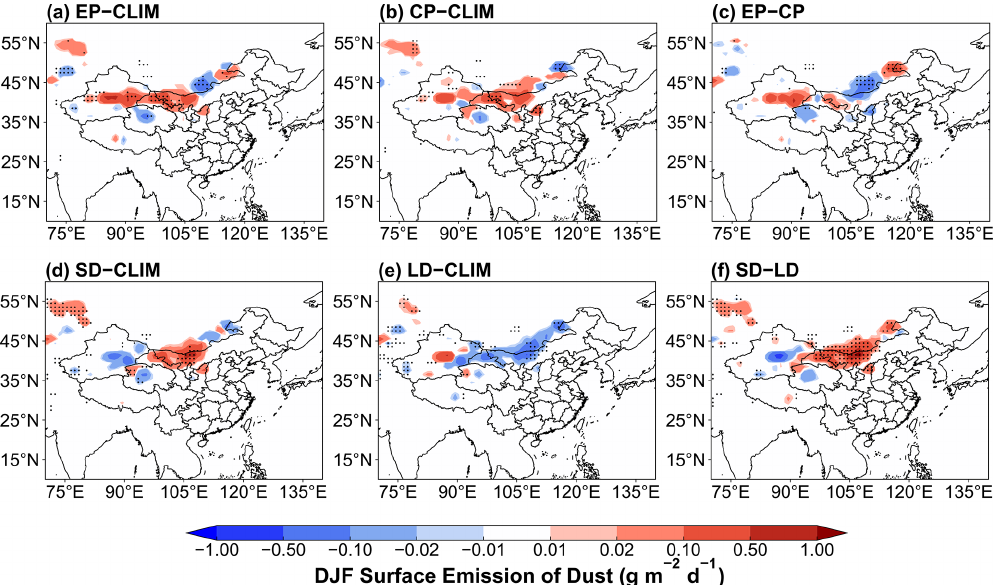
Figure 7. Composite differences in DJF mean dust emissions (gm − 2 d − 1 ) between EP and CLIM in (a) , CP and CLIM in (b) , EP and CP in (c) , SD and CLIM in (d) , LD and CLIM in (e) , and SD and LD in (f) . The stippled areas indicate statistical significance with 90% confidence from a two-tailed t